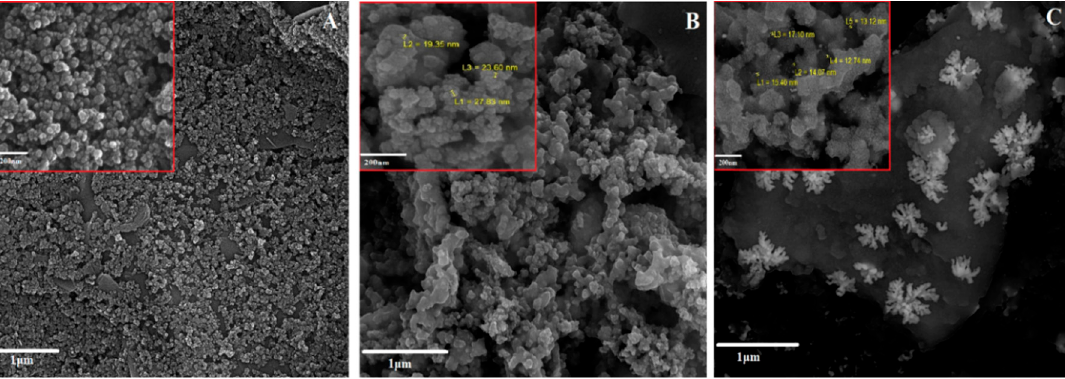
Figure 2. Characterization of sensing interface. FE-SEM images of ( A ) bare SPE, ( B ) Fe 3 O 4 @SiO 2 /DABCO/SPE, and ( C ) DGNs/Fe 3 O 4 @SiO 2 /DABCO/SPE. The measured particle size is indicated in yellow color. The scale bars in the high (inset) and low magnification are 200 nm and 1 µ m, respectively.